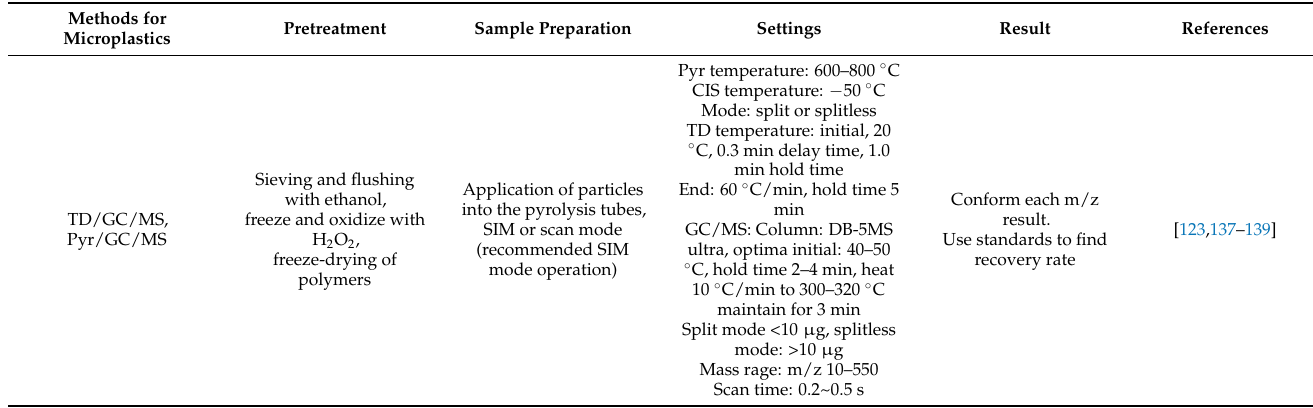
Table 7. TD and Pyr/GC/MS setting condition for microplastic